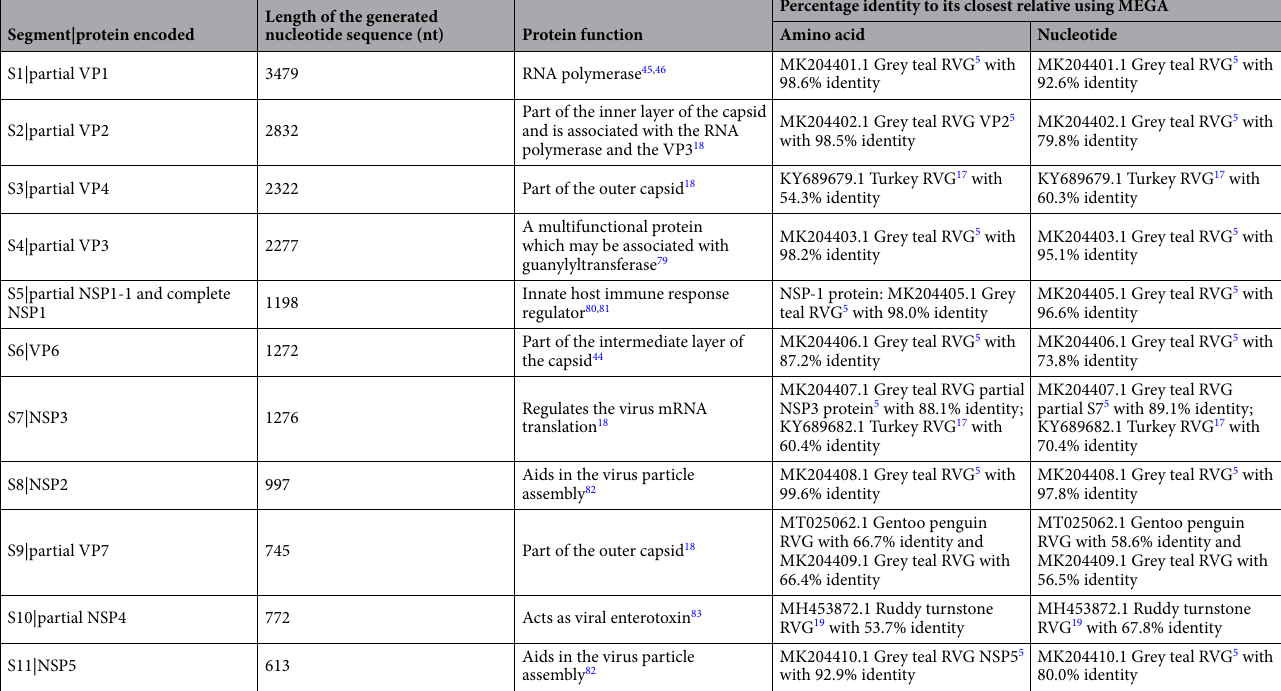
Table 3. Details on the rotavirus G from Pacific black duck 08.18 sample (PBDRVG/PBD08.18).